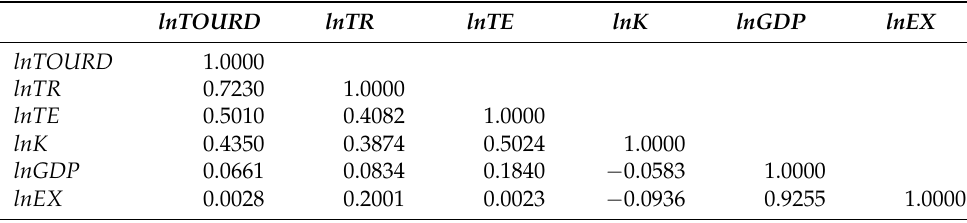
Table A1. Correlation